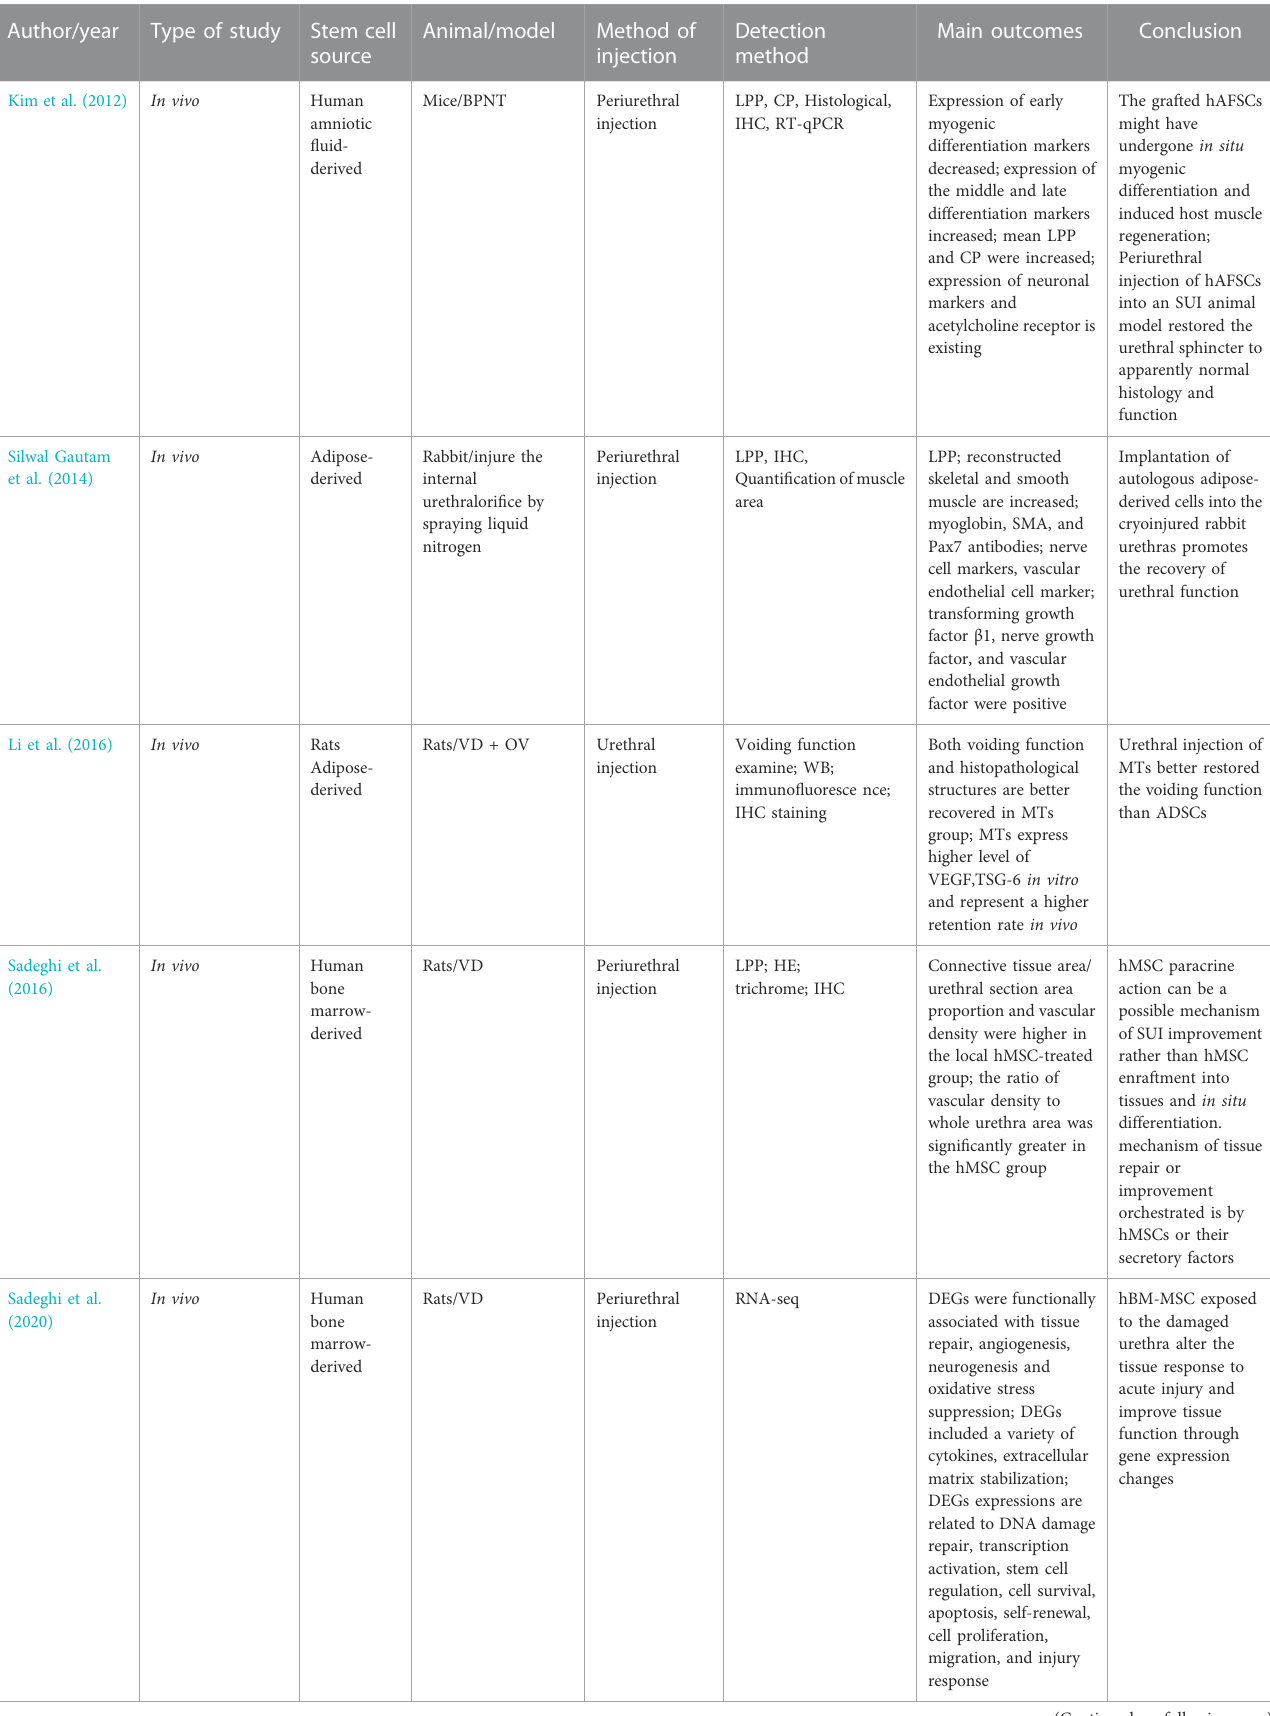
TABLE 1 Study characteristics dealing with Single type of MSC therapy for stress urinary